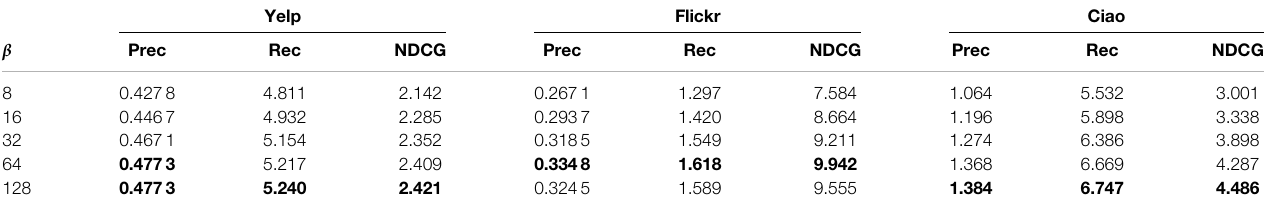
TABLE 11 | Performance of CGL with respect to different embedding sizes d ( K = 20). The best results are in bold. Yelp Flickr Ciao